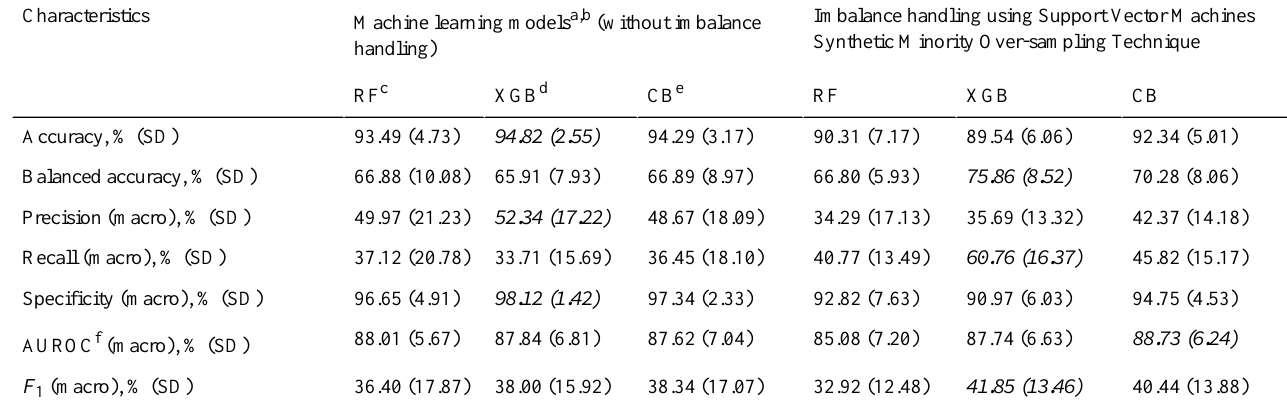
Table 4. Results of the personalized models for emotional transition detection on the basis of the 5-fold, stratified cross-validation.